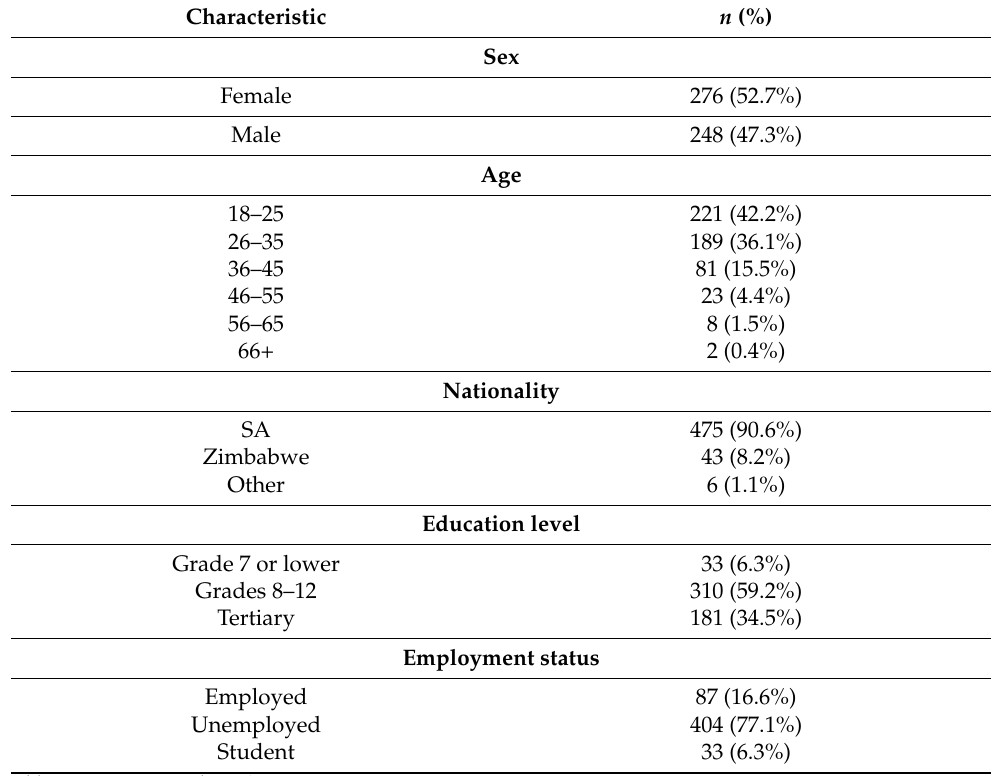
Table 1. Participant demographic characteristics.